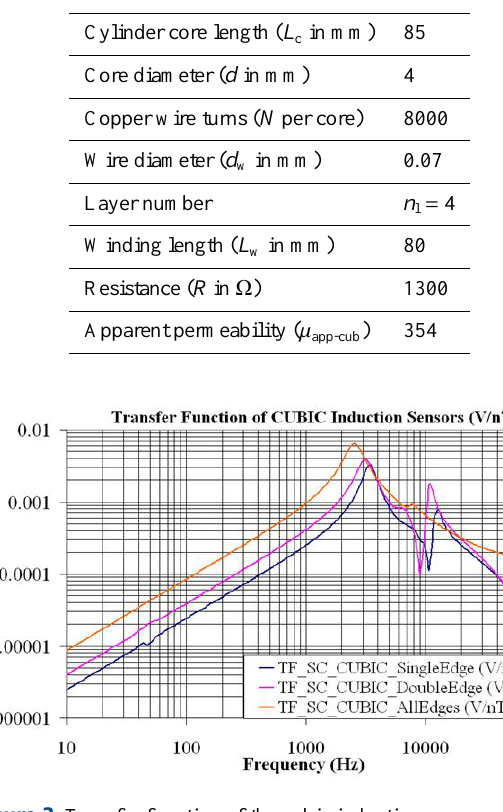
Figure 3. Transfer function of the cubic induction sensor: one edge (dark blue), two edges (pink) and four edges (orange